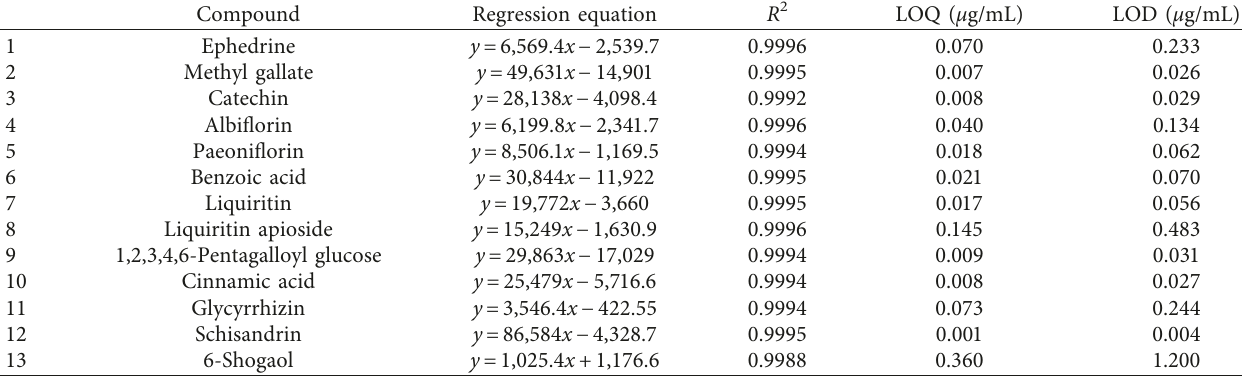
Table 1: Regression data, LODs, and LOQs for the marker compounds analyzed by UPLC. Compound Regression